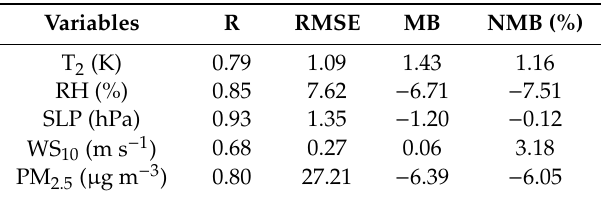
Table 1. Statistical metrics between observed and simulated meteorological parameters and PM 2.5 concentrations averaged over the THB.